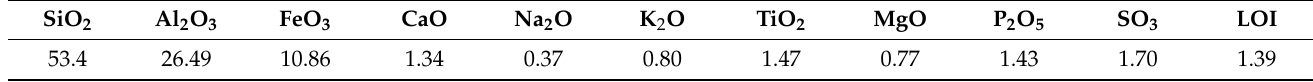
Table 2. Chemical Compositions of Fly ash.